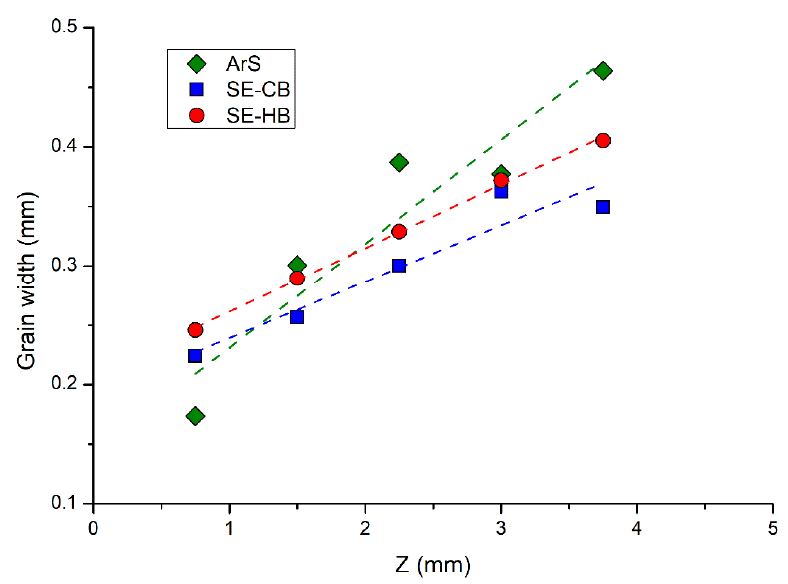
Figure 6. Prior- β grain average width and relative linear interpolation for all conditions plotted as a function of Z.